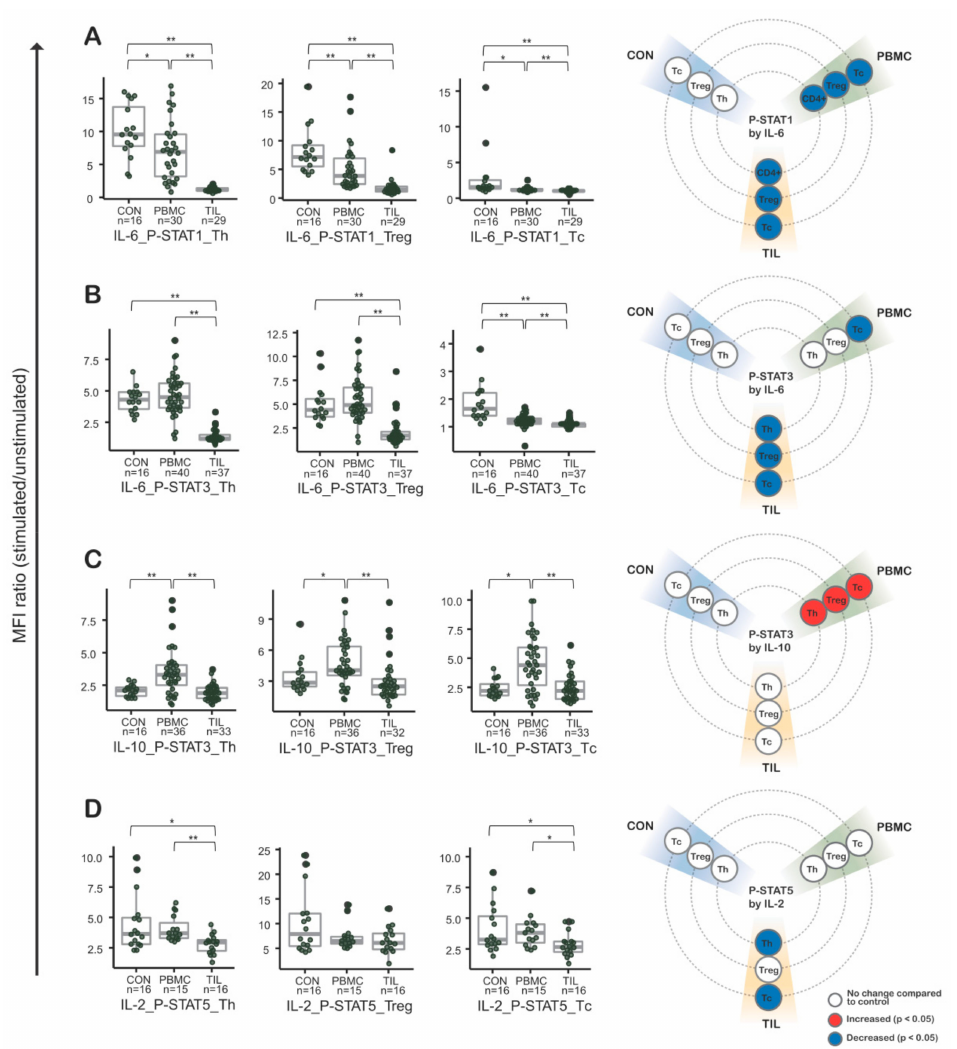
Figure 2. Cytokine induced phosphorylated STAT (CIPS) signatures in peripheral blood mononuclear cells (PBMCs) and tumor infiltrating lymphocytes (TILs) from colorectal cancer (CRC) patients (n = 50). Phospho-flow cytometry was performed in combination for IL-6 and STAT1 ( A ), IL-6 and STAT3 ( B ), IL-10 and STAT10 ( C ), and IL-2 and STAT5 ( D ). In the first three plots (from the left), CIPS signatures were tested in helper T cells, regulatory T cells, and cytotoxic T cells. To the far right is a visualization summarizing each CIPS signature. CON, control peripheral blood mononuclear cells from healthy blood donors; PBMC, peripheral blood mononuclear cells from colorectal cancer patients; TILs, tumor-infiltrating lymphocytes from colorectal cancer patients; CRC, colorectal cancer.; *, p -values < 0.05; **, p -values < 0.01 in Mann-Whitney-Wilcoxon test; middle line in box plot